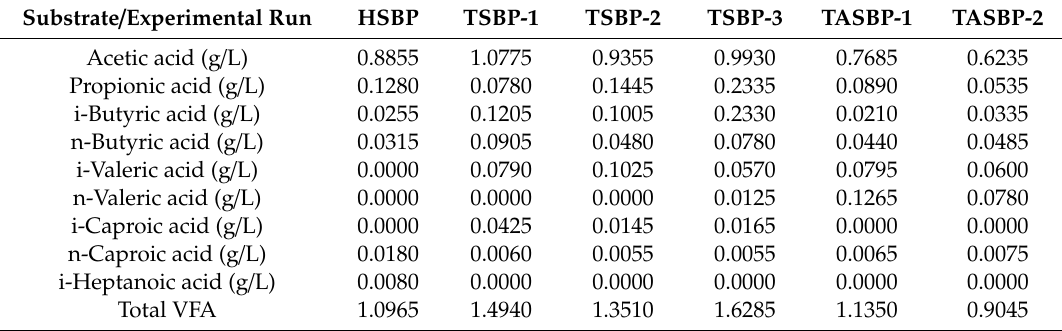
Table 5. Concentrations of individual organic acids in the